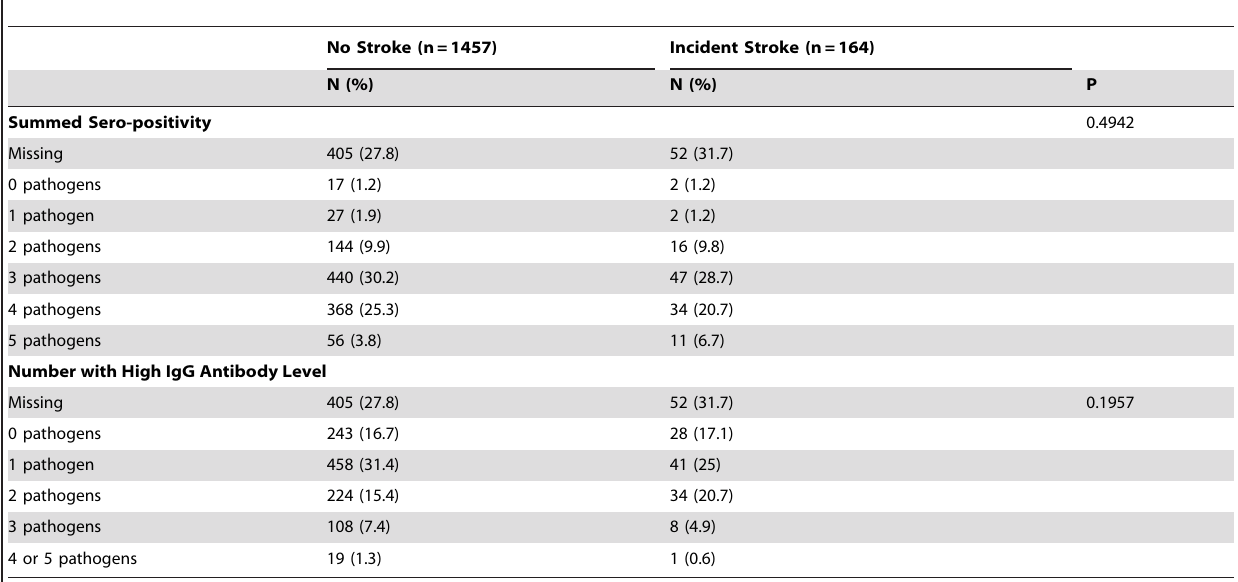
Table 2. Baseline Pathogen Burden Defined as Summed Sero-positivity and Number of Pathogens With High IgG Antibody Level, by Incident Stroke Status, SALSA, California, 1998–2008.